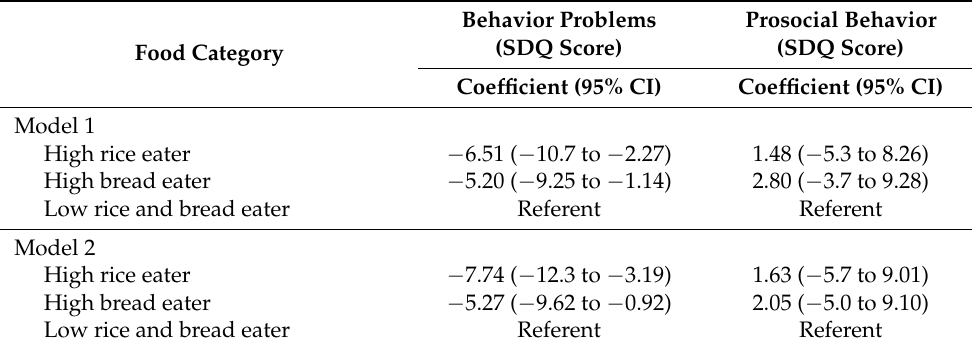
Table 4. Results of regression analyses on children’s mental health according to types of grain dishes among Japanese school children ( n =